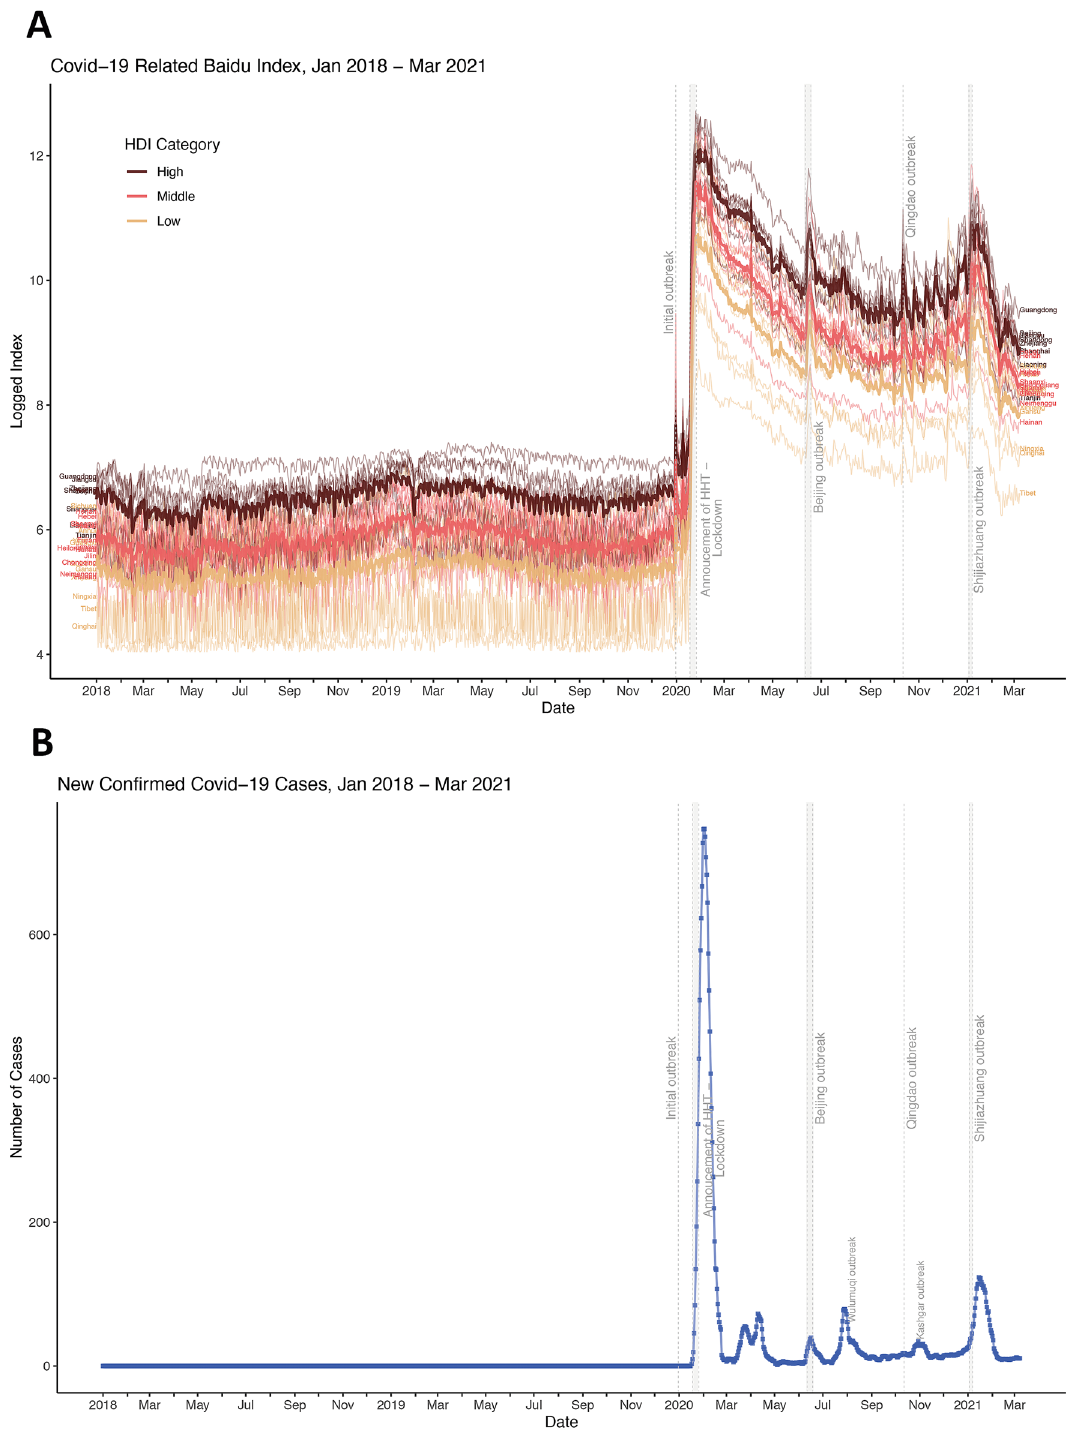
Figure 1. Baidu search index by province and number of new confirmed cases over time. ( A ) Observed daily search index (log transformed) by province and HDI category over time. Aggregated search index by HDI category over time is shown in Fig. S1. ( B ) Daily new confirmed COVID-19 in China (cases in Hubei provinces are